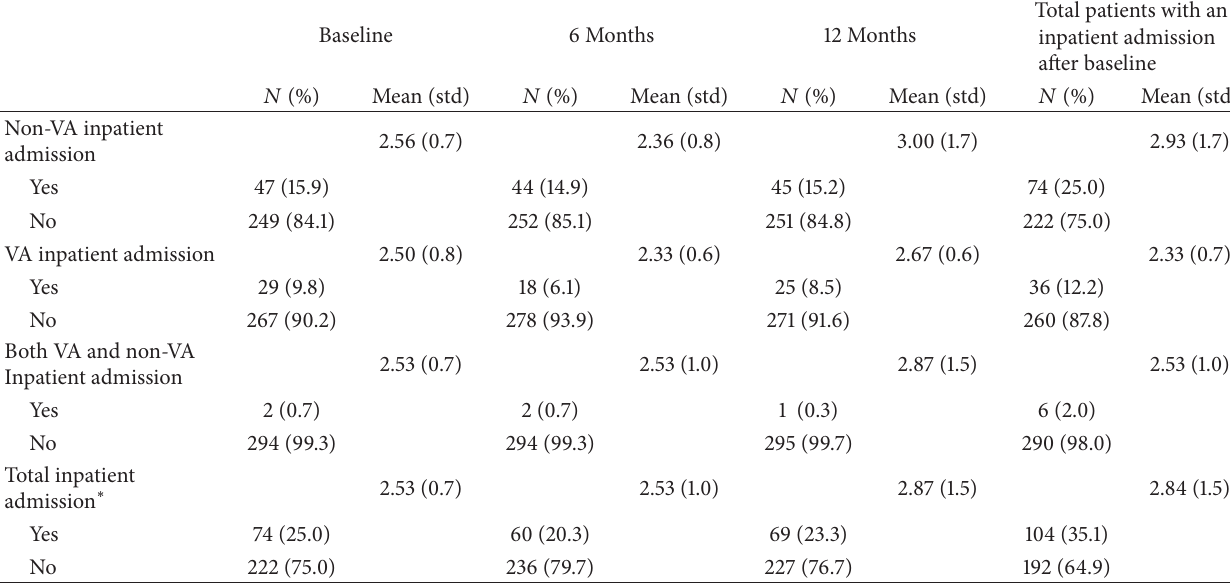
Table 2: Number of veterans with inpatient hospital admissions over 12